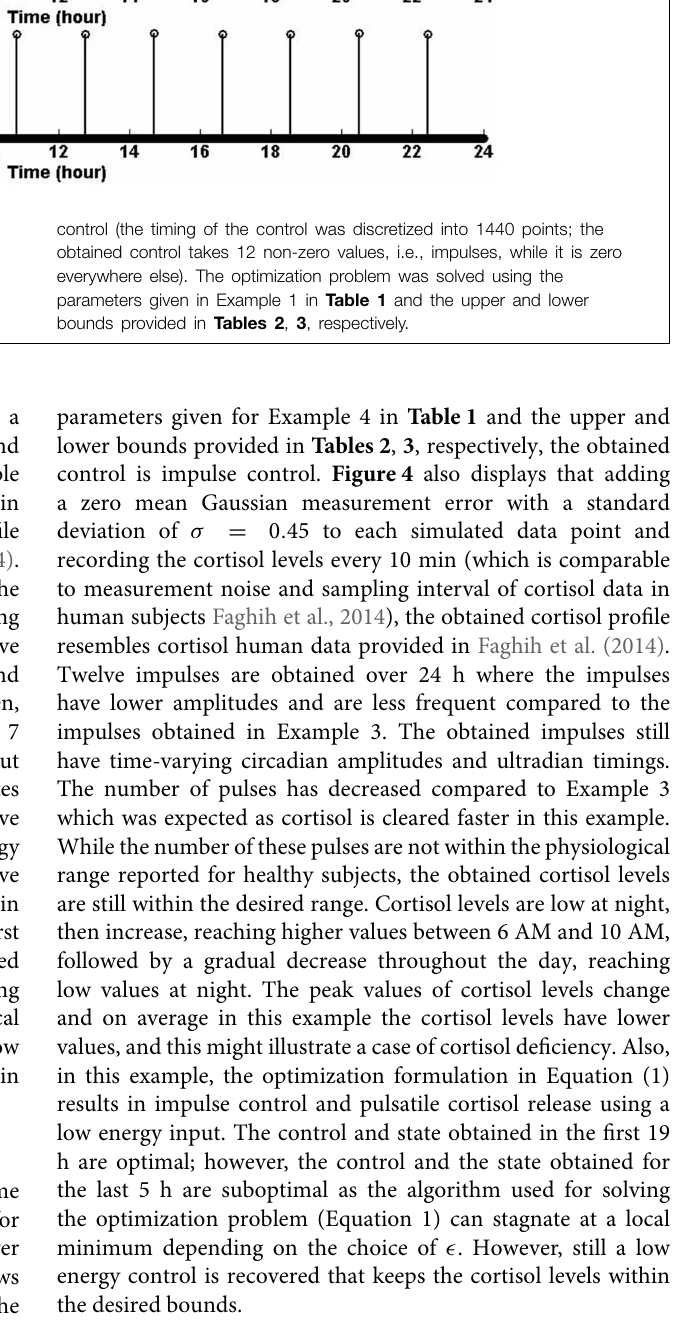
control (the timing of the control was discretized into 1440 points; the obtained control takes 12 non-zero values, i.e., impulses, while it is zero everywhere else). The optimization problem was solved using the parameters given in Example 1 in Table 1 and the upper and lower bounds provided in Tables 2 , 3 ,